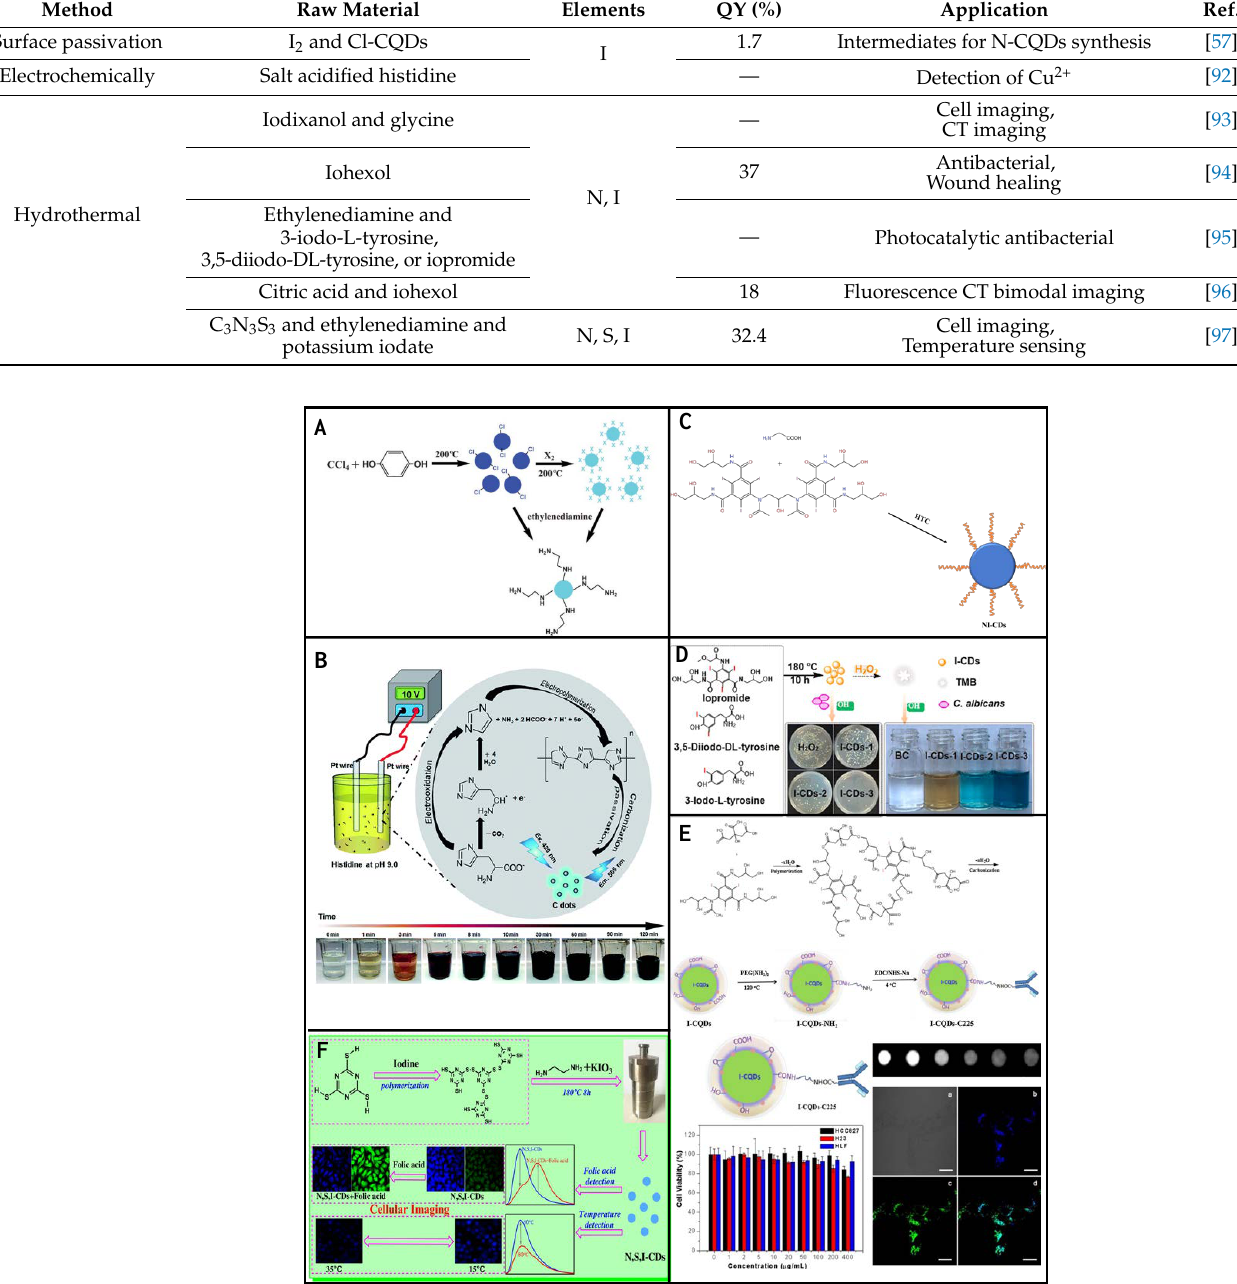
Table 4. Synthesis methods, raw materials, and applications of I-CDs.